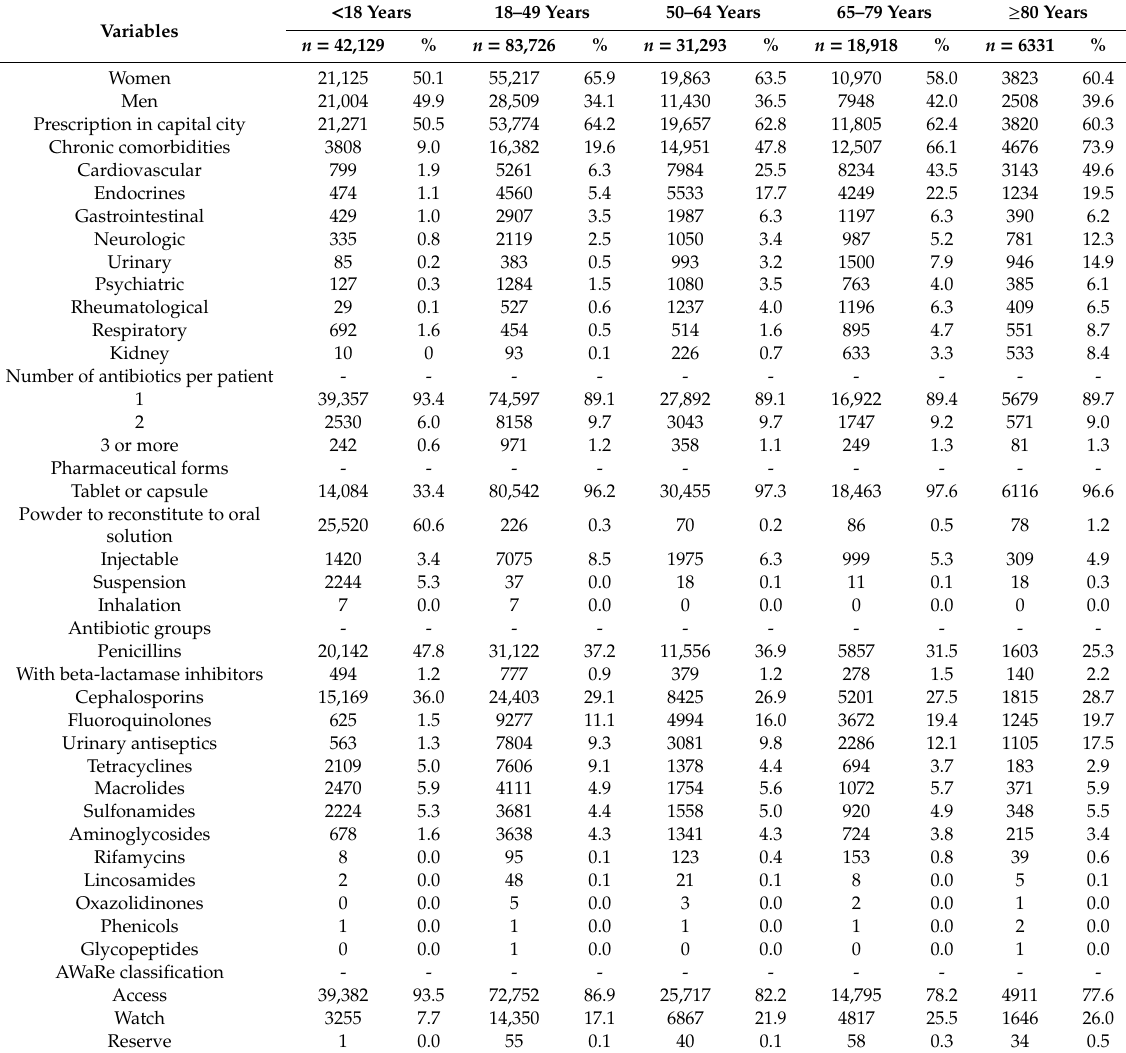
Table 3. Distribution of the antibiotic prescription in the study sample according to the age group. Variables